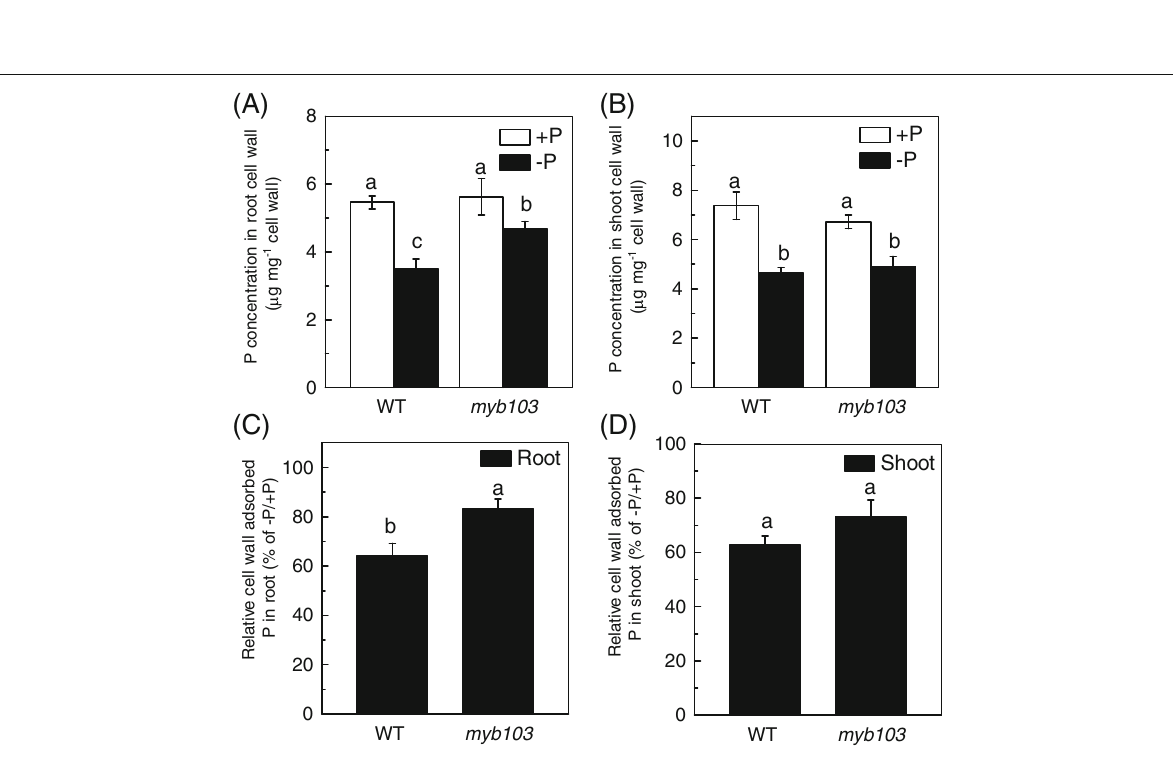
Fig. 5 Cell wall P concentration. Seedlings were hydroponically treated with +P or -P solution for 7 d, and the P concentrations were measured in the root ( a ) and shoot ( b ) cell wall. The relative cell-wall-adsorbed P in the root ( c ) and shoot ( d ) was calculated from the P concentration in the root or shoot cell wall under -P / the P concentration in the root or shoot cell wall under +P. Values are means ± SD, n = 4. Different letters on the bars indicate significant differences at p <